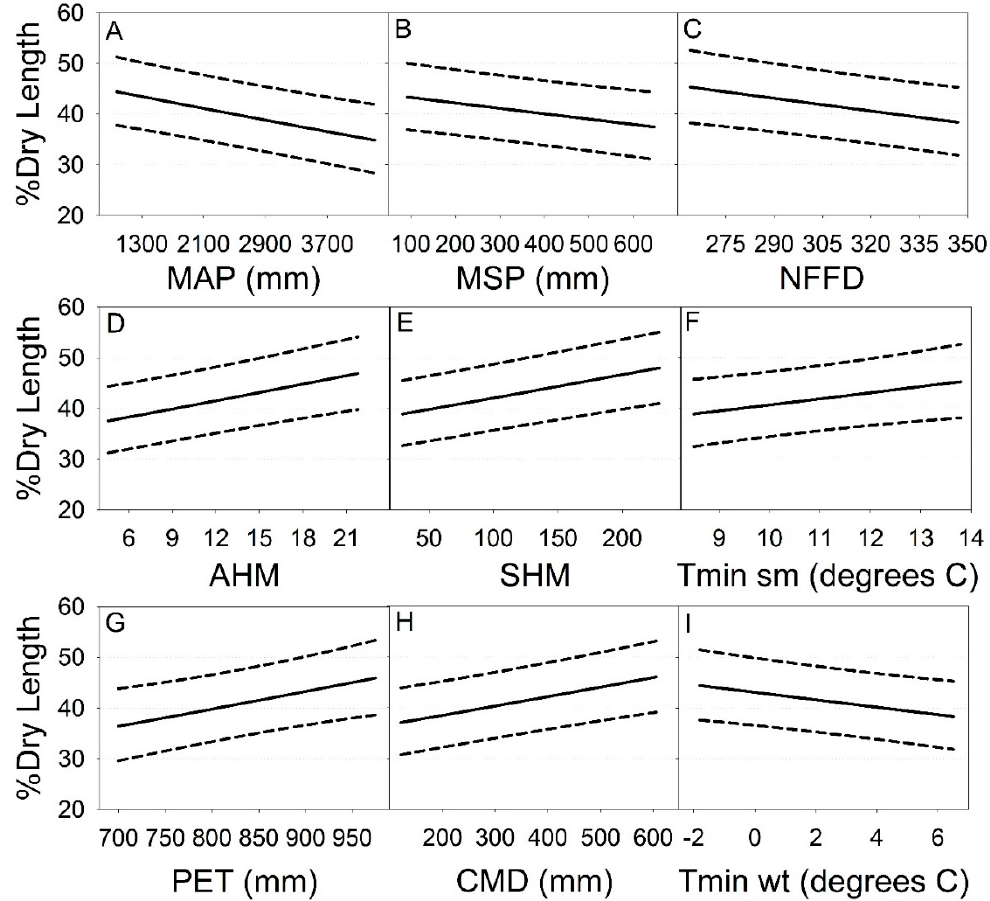
Figure 6. Modeled relationships between % dry stream-reach length and climate variables. Solid lines are predicted values from simple linear mixed models, dashed lines show upper and lower 95% confidence intervals. Nested random effects for site, stream and reaches (repeated) are not shown. MAP = mean annual precipitation ( A ), MSP = mean summer precipitation ( B ), NFFD = Number of frost-free days ( C ), AHM = annual heat: moisture index ( D ), SHM = summer heat: moisture index ( E ), Tmin sm = mean minimum summer temperature ( F ), PET = potential evapotranspiration ( G ), CMD = climatic moisture deficit ( H ), and Tmin wt = mean minimum winter temperature ( I ).